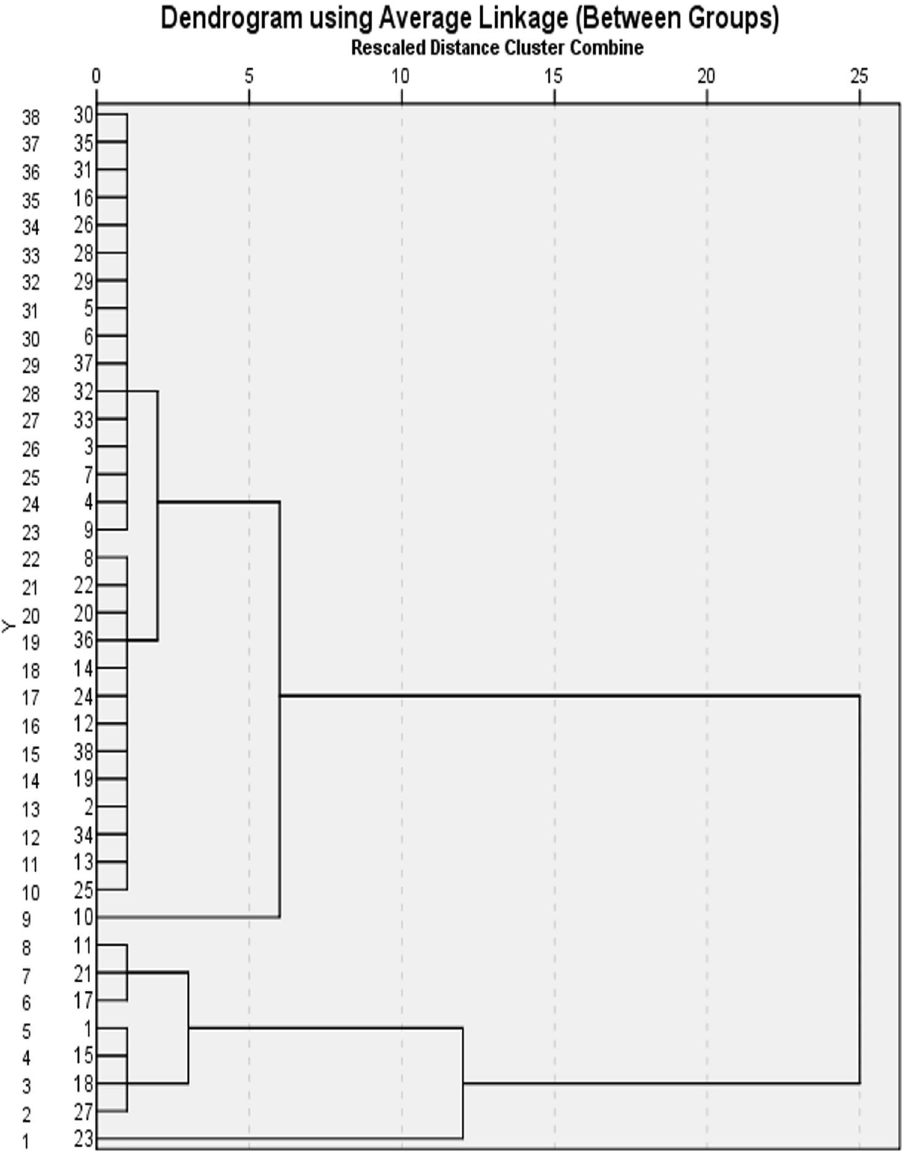
Fig. 1 Cluster analysis dendro- gram of the